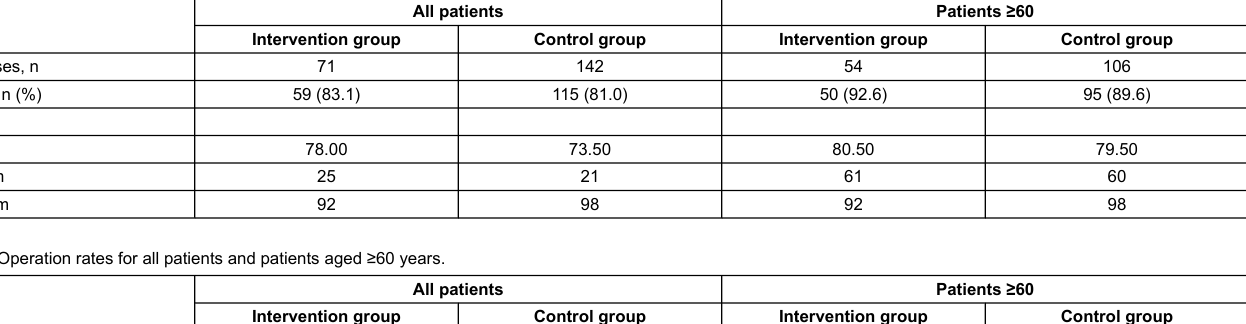
Table 1: Baseline characteristics for all patients and patients aged ≥60 years.